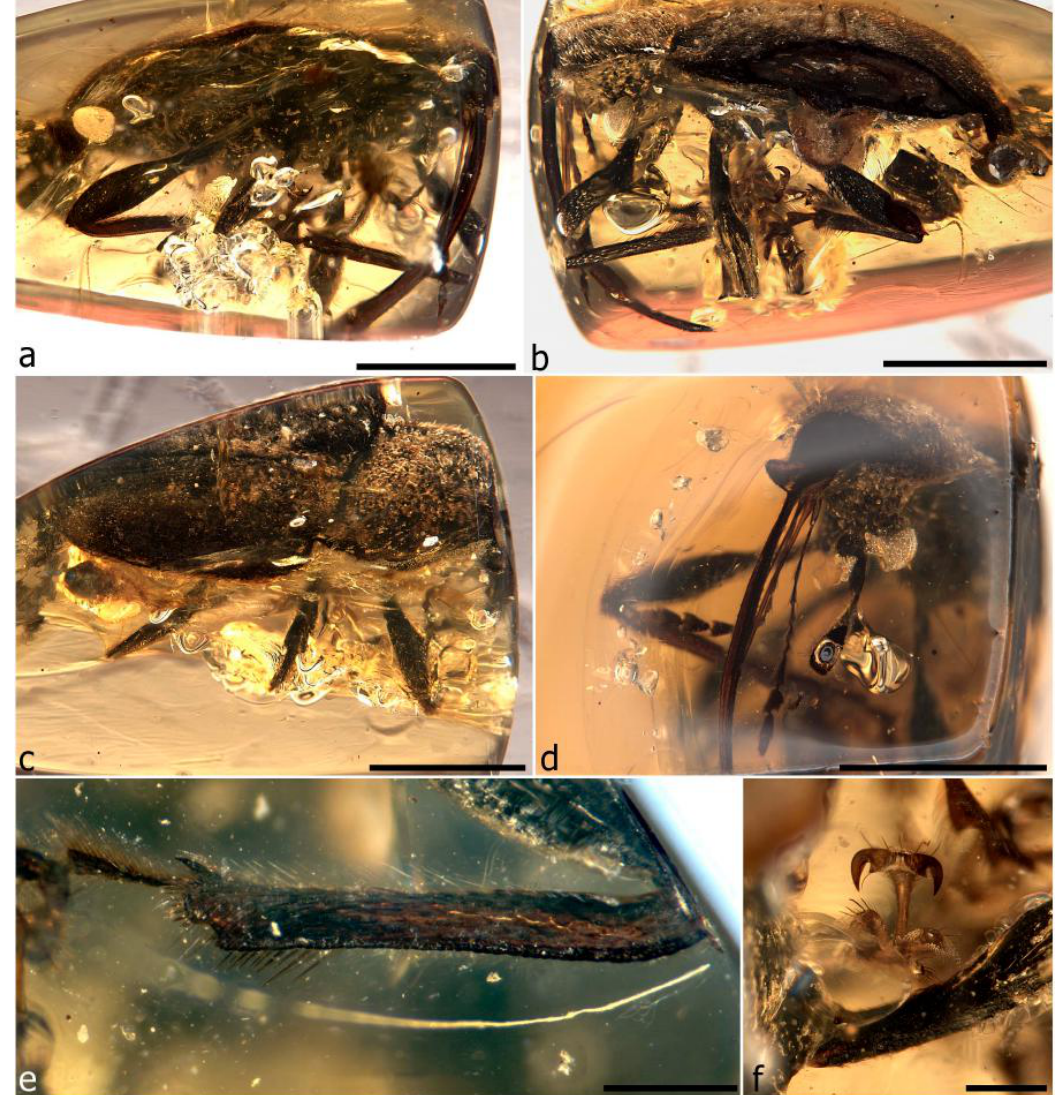
Figure 61. Mekorhamphus gracillipes sp. n., paratype. Habitus, right lateral ( a ); habitus, left lateral ( b ); habitus, dorsal ( c ); head and antennae, frontolateral ( d ); right metatibia showing subdued crenulation ( e ); claw, apical ( f ). Scale bars: 1.0 mm ( a – d ); 0.2 mm (e,f). Mekorhamphus tenuicornis Clarke & Oberprieler, sp. n. (Figure 62) Description. Size. Length 2.85 mm, width 0.95 mm. Head subglobular. Eyes dorsally narrowly separated. Rostrum longer than pronotum; antennal insertions in middle of rostral length, behind them with long narrow scrobes extending to eye, in apical quarter with lateral row of few long, erect setae. No gular suture visible. Antennae. Scapes apically abruptly clavate, strongly oblique; funicles slightly longer than scape, segments elongate, thin, 6 and 7 somewhat shorter and broader; clubs flattened, with segment 4 distinct. Mouthparts . Mandibles with 3 triangular teeth on outside and narrow apical point. Thorax . Prothorax strongly proclinate. Pronotum elongate, laterally without tooth, posterior angles acute, fitting onto elytra; sparsely setose, setae inserted on small tubercles, moderately long, thin, dark brown. Prosternum with position of procoxal cavities not discernible. Scutellar shield small, transverse (obscured). Metaventrite convex. Elytra elongate, with well-developed, broadly rounded humeri, anterior bases lobed, enclosing scutellar shield, posteriorly gently declivous, apically individually rounded; surface coarsely punctostriate but striae faint, interstriae narrow, roundly subcarinate, with sparsely vestiture of long, thin, dark brown,